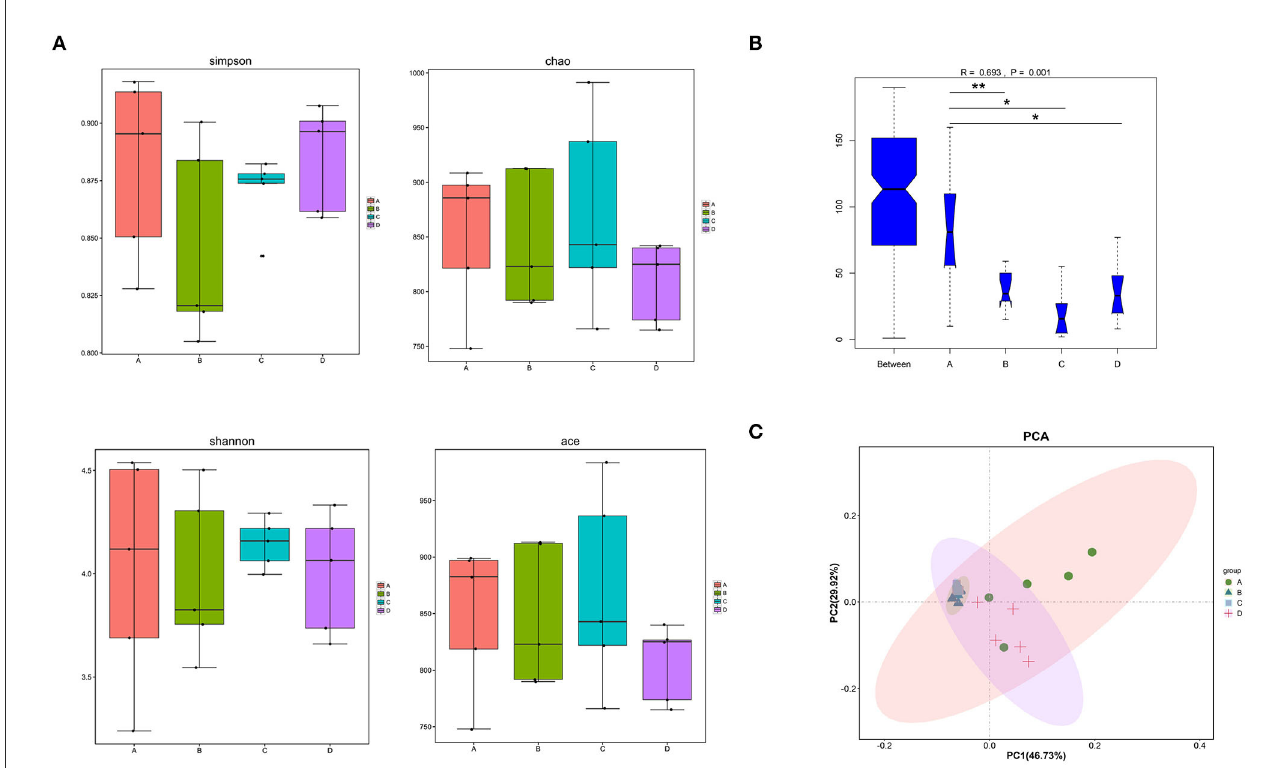
FIGURE3 Differences in the gut microbiota among the four groups. (A) alpha diversities. (B) beta diversities (* p < 0.05; ** p < 0.01). (C) PCA at the genus